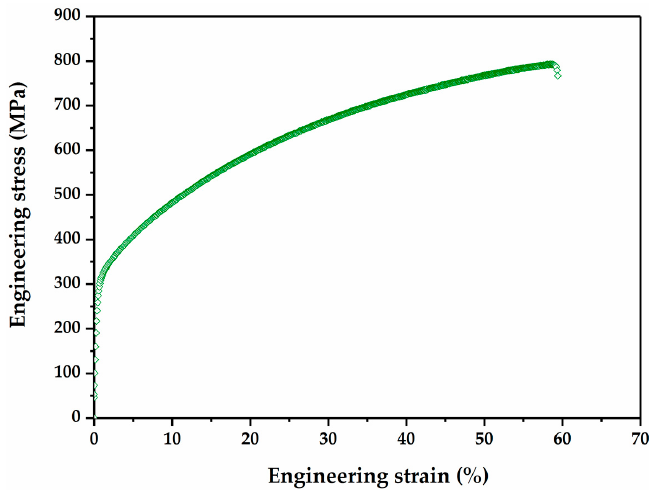
Figure 9. Engineering stress–engineering strain curve of the Fe-17Mn-1.5Al-0.3C steel tested at room temperature and a strain rate of 1 × 10 − 3 s − 1 . Table 3. Mechanical properties of the Fe-17Mn-1.5Al-0.3C steel.